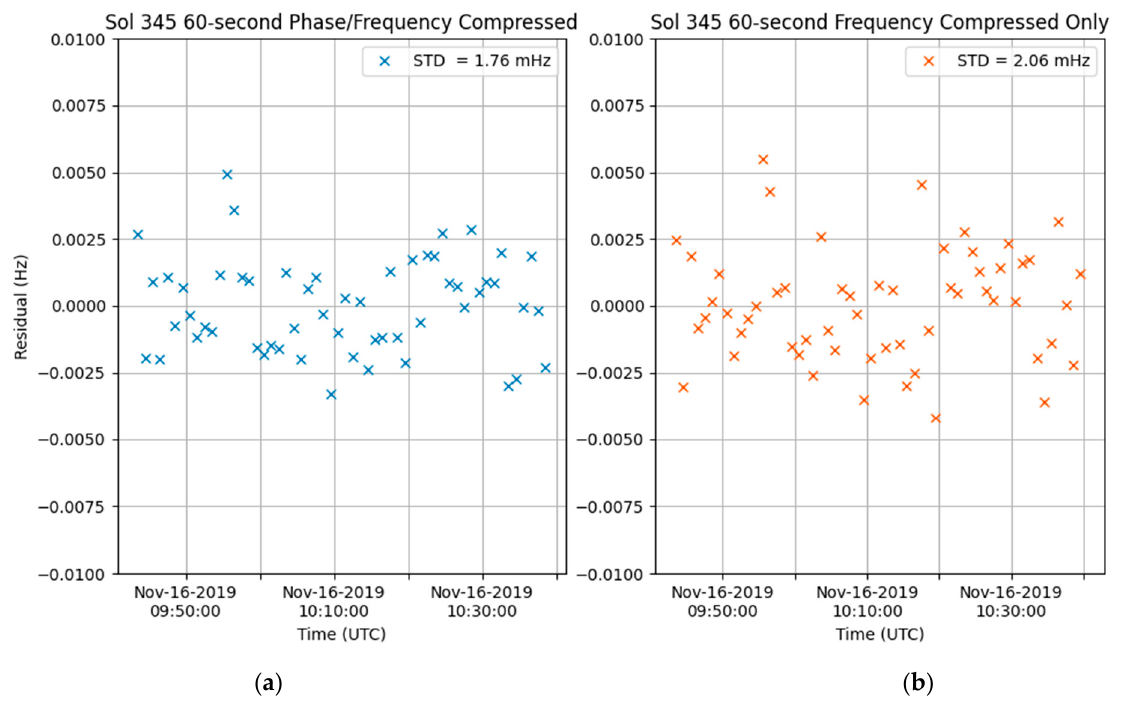
Figure 5. Doppler residuals at 60 s count-time for Sol 345 with two compression methods. Left ( a ), using phase compression from 0.1 s to 20 s using phase averaging followed by frequency compression from 20 s to 60 s; and right ( b ), using frequency compression from 0.1 s to 60 s only.